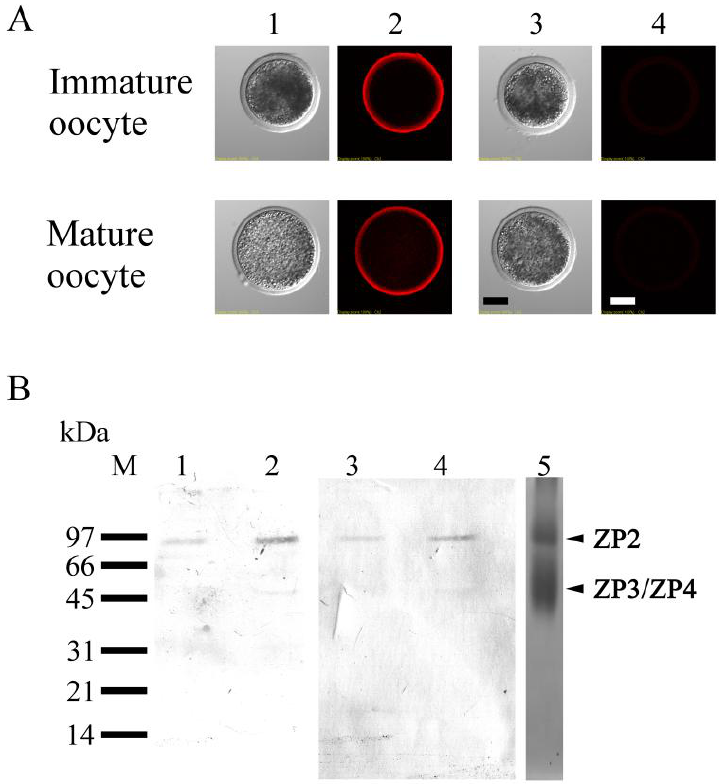
Figure 6. Localization of porcine ZP2 in immature and mature oocytes. ( A ) Indirect immunostaining of porcine immature and mature oocytes using anti-porcine ZP2 (panels 1 and 2), and without antibody (panels 3 and 4). Panels 1 and 3, phase-contrast; panels 2 and 4, fluorescence. ( B ) GNA-lectin blots (lanes 1 and 2) and Western blots using anti-porcine ZP2 (lanes 3 and 4) of porcine-zona protein mixtures from immature (lanes 1 and 3) and mature (lanes 2 and 4) oocytes. Silver staining of immature, porcine-zona protein mixture prepared from cryopreserved ovaries (lane 5) shows the positions of ZP2, ZP3, and ZP4. Scale bar = 50